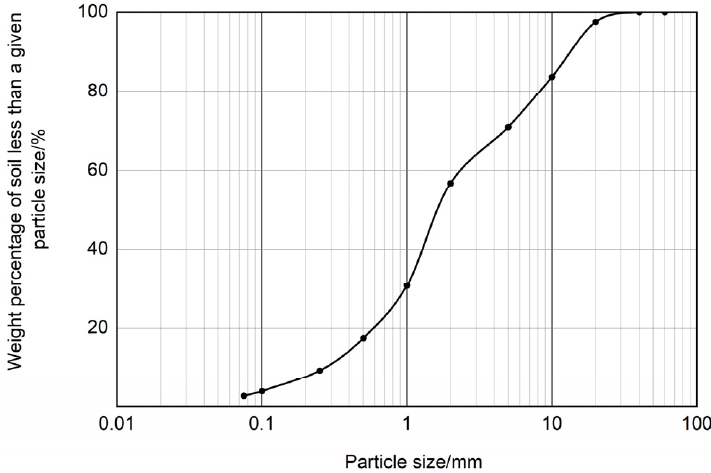
Figure 1. Particle size distribution curve of the tested soils.